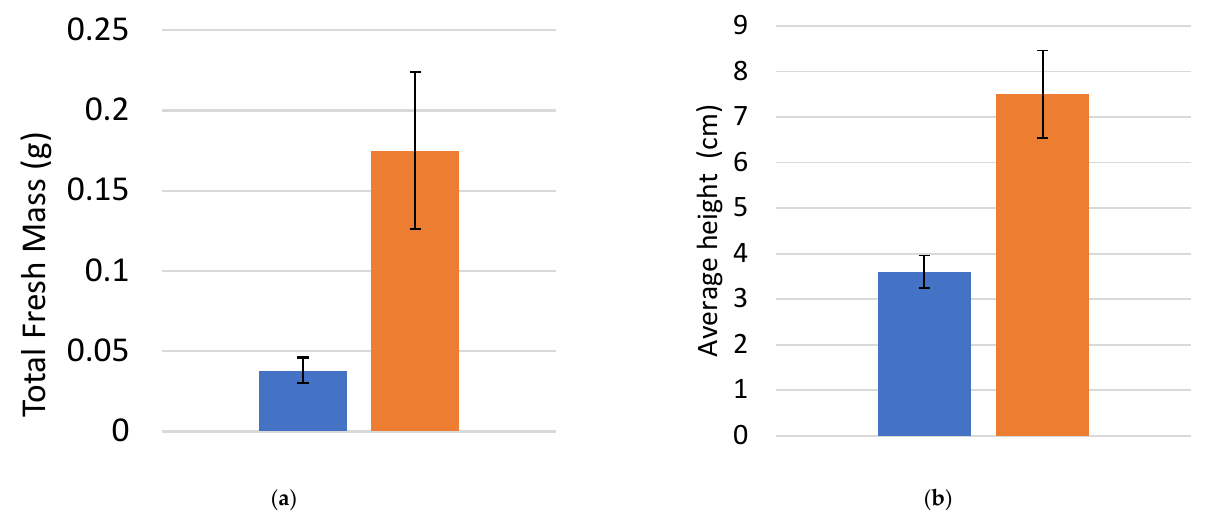
Figure 3. Comparison of Irish peat (in blue) and Organic soil (in orange) considering: ( a ) Total Fresh Mass and ( b ) Average height. Error bars indicate the standard deviation on the average values.